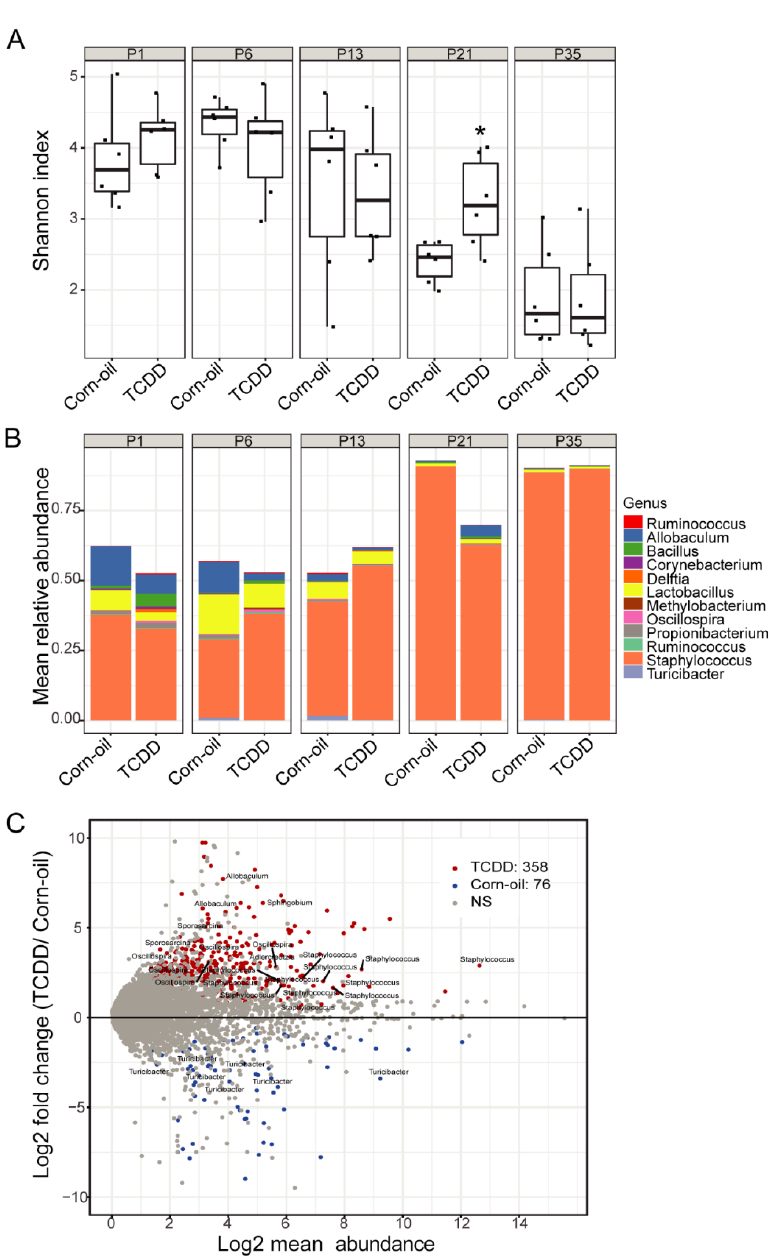
Figure 8. TCDD effects on murine skin microbiota revealed by 16S rRNA gene sequencing. Time- mated mice were treated by gavage with either corn-oil or TCDD (5 µ g/kg bw) and pups were analyzed for effects on the skin microbiome. ( A ) Alpha diversity of skin microbiota as measured by Shannon index (y-axis) following the indicated treatments and time. Data are displayed as box plots. Each symbol represents an individual animal ( n = 6). Data were analyzed by the Wilcoxon rank sum test. * p < 0.05, compared to age-matched corn-oil control. ( B ) Stacked bar plot of mean relative abundance (y-axis) of the top 12 genera identified in the skin microbiota following the indicated treatments and time. ( C ) MA-plot comparing differentially enriched OTUs between corn-oil- or TCDD-treated skin microbiota at P21. Shown is log2 mean abundance (x-axis) and log2 fold-change of normalized OTU counts (y-axis). Color of points indicates whether OTUs were significantly in- creased in TCDD (red), corn-oil (blue), or not significant (NS; grey). The top 30 most significant OTUs that have a genus-level taxonomy assignment are highlighted. Abbreviations: TCDD, 2,3,7,8- tetrachlorodibenzo- p -dioxin; bw, body weight; P, postnatal day; OTU, operational taxonomic unit.